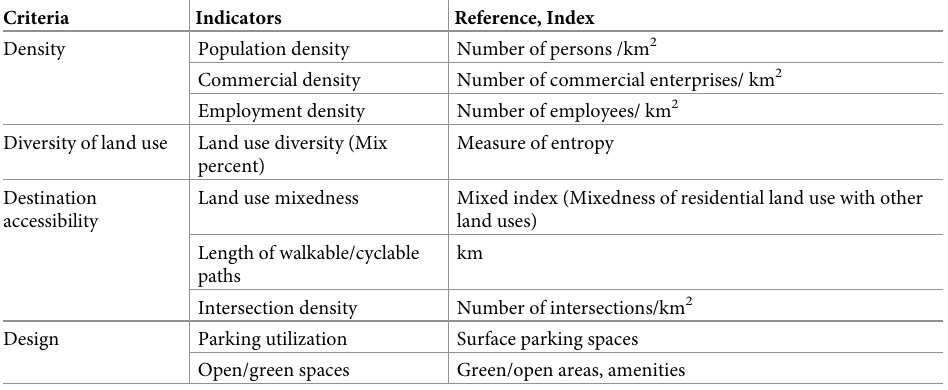
Table 1. Criteria and indicators for gauging TOD